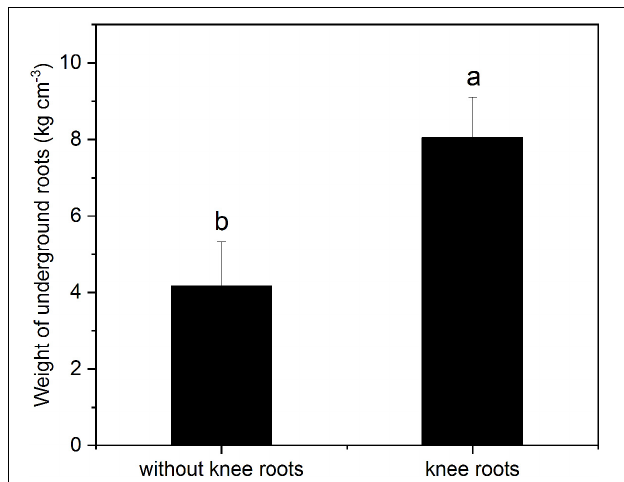
FIGURE 4 | Weight of underground roots with or without knee roots. Values followed by the same letter(s) are not significantly different at P < 0.05, according to Duncan’s multiple range tests. Error bars are SD of the mean; n = 3.